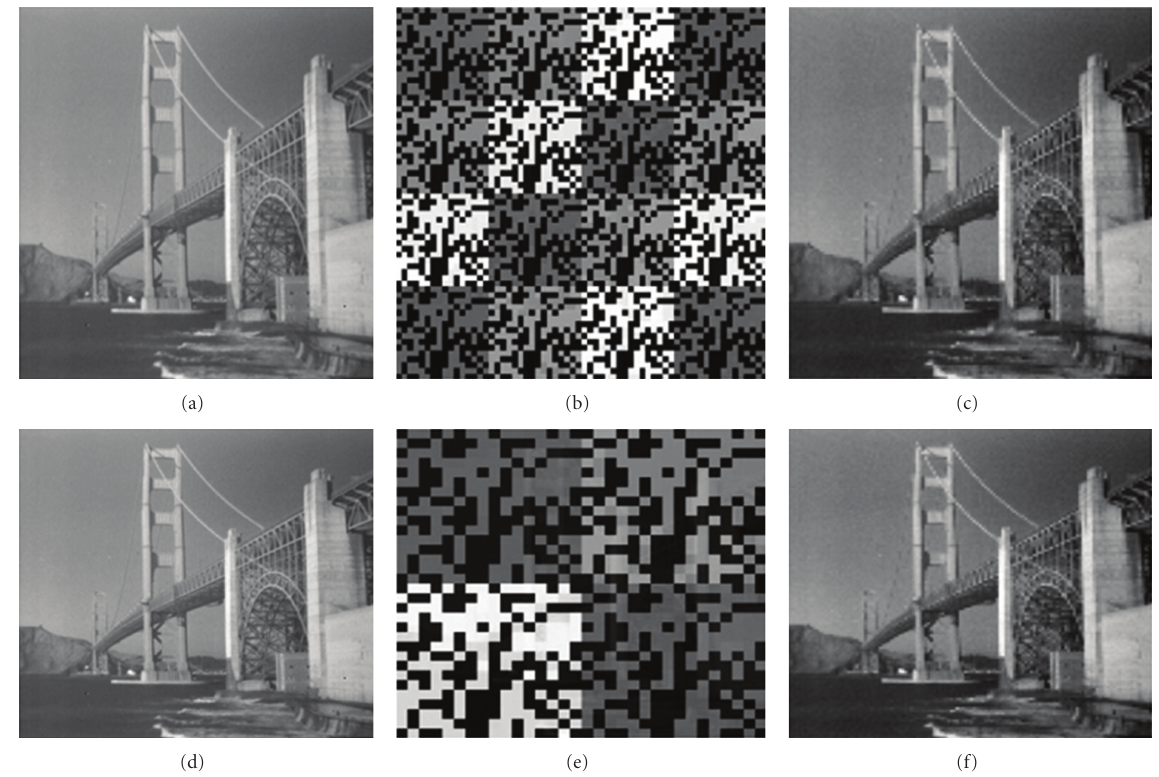
Figure 6: Results of application of chaotic algorithm to SF.GIF. (a) and (d) original image. (b) image resulting from encryption with L1 or L2, respectively, using three external encryption keys in the larger size. (c) and (f) reconstructed image in each